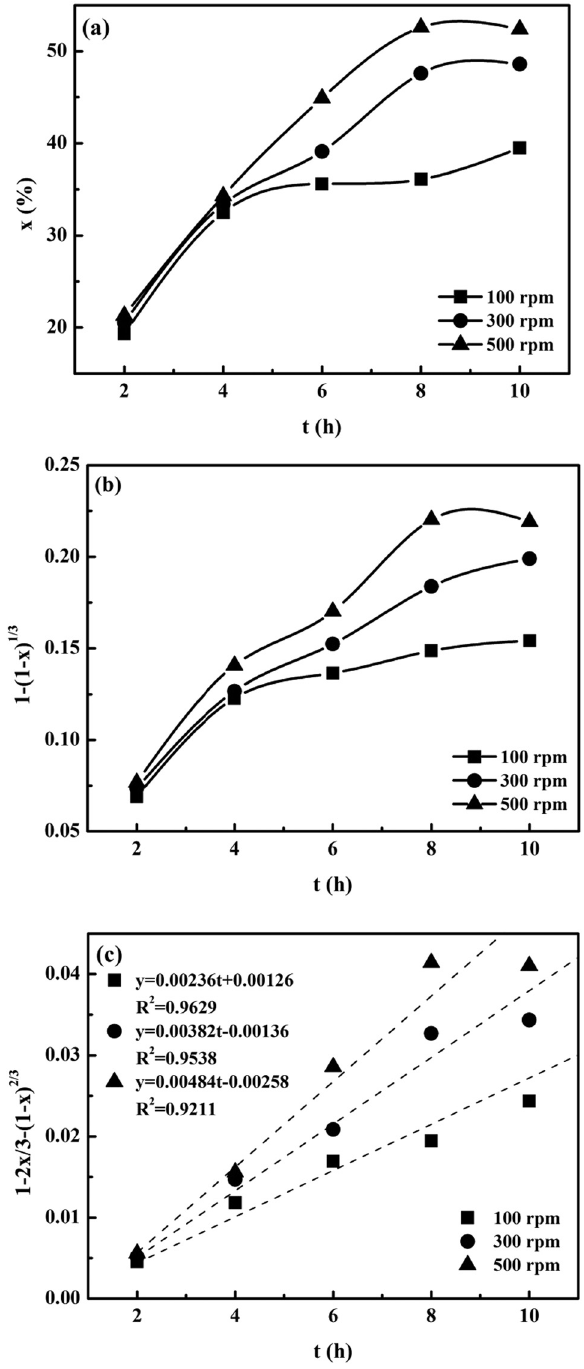
Figure 4: The relationship between ( a ) t and x , ( b ) t